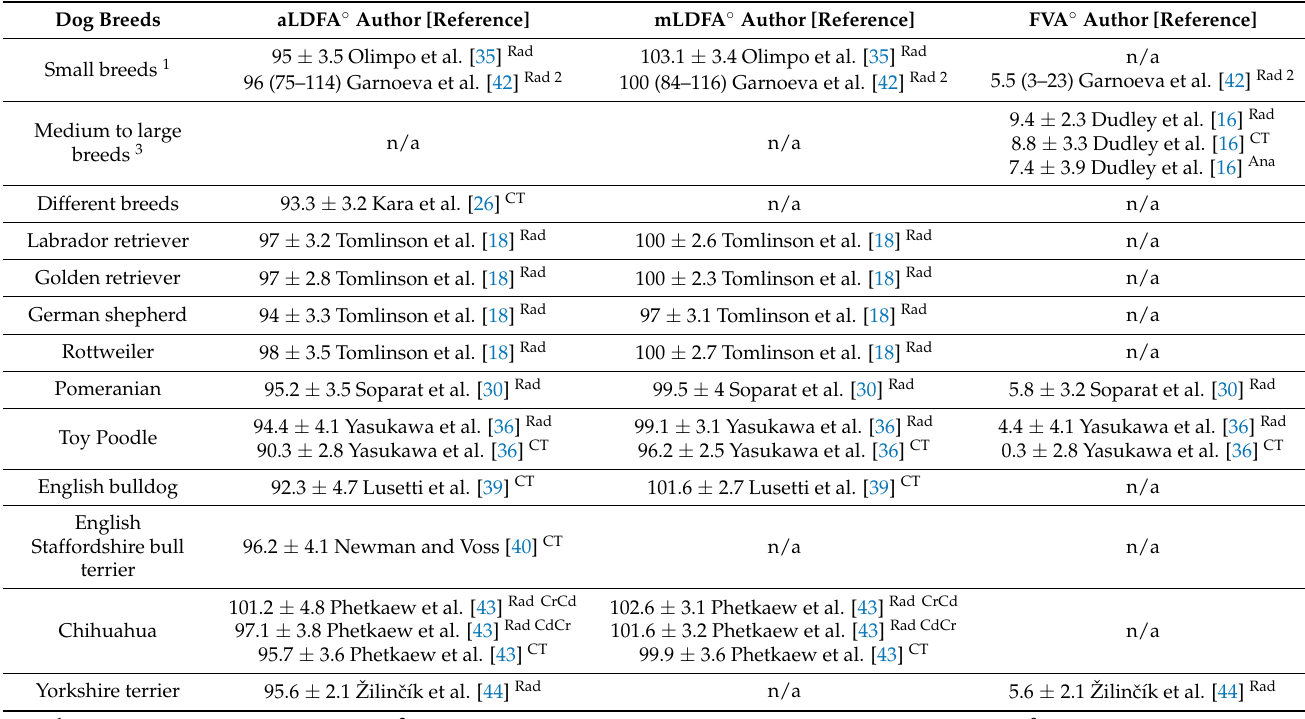
Table 8. Mean ± standard deviation of anatomical lateral distal femoral angle, mechanical lateral distal femoral angle, and femoral varus angle in healthy